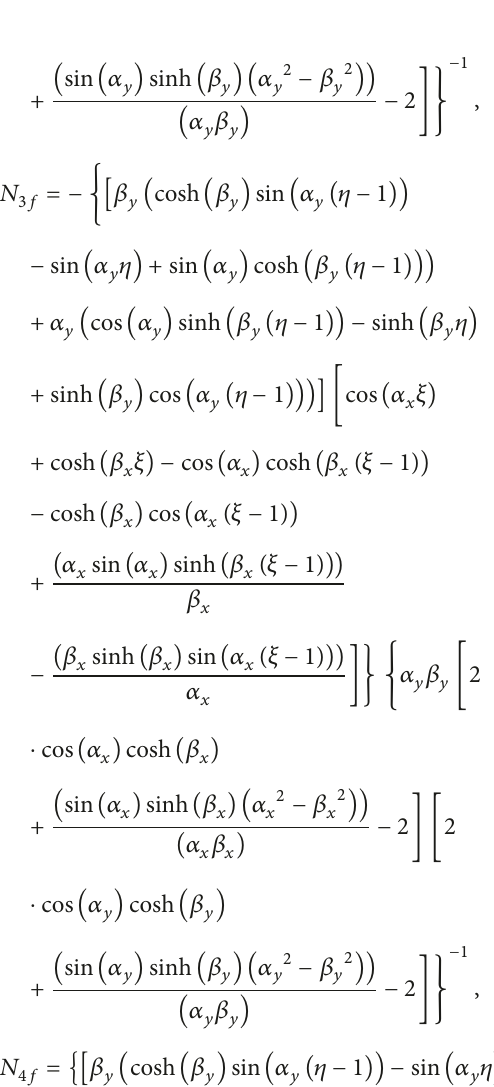
Figure 12: Shape function 𝑁 13𝑓 at 𝜔 1 (a) and 𝜔 2